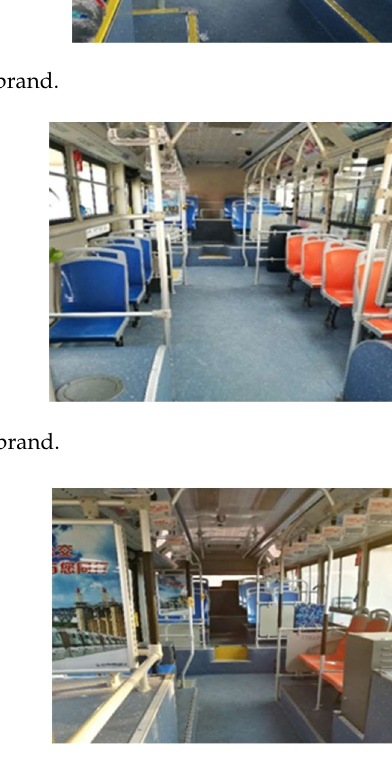
Figure 4. Jiankang brand.